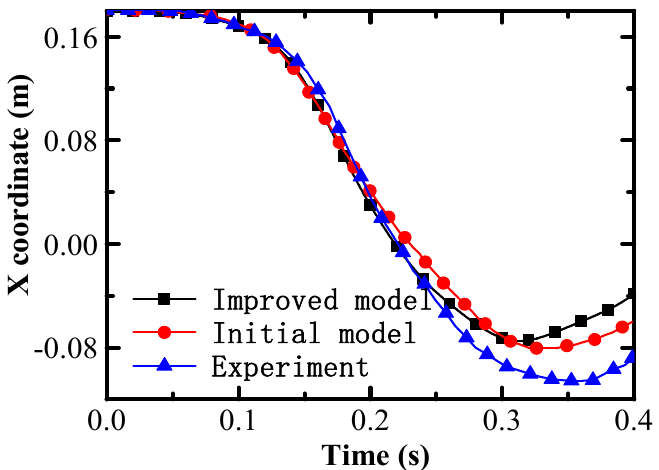
Figure 6. The X coordinate comparison of point P (experimental data are cited from reference [21]).